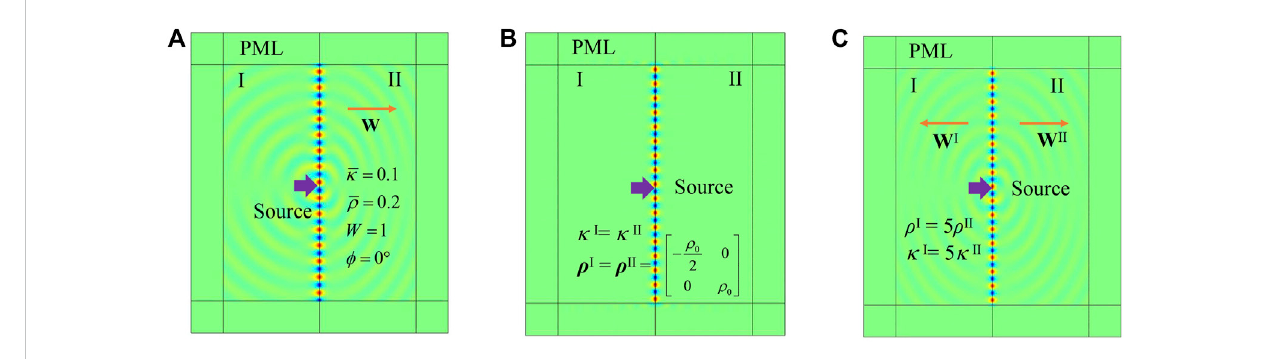
FIGURE 7 FEMsimulationsofinterfacewaves(pressure fi eld). (A) MediumI,anordinarymedium;MediumII,aWillismedium. (B) BothsidesareWillismediawith parameters that satisfy Eq. 17. (C) Both sides are Willis media with parameters that satisfy Eq. 18. In (A) , (B), and (C) , the sources are 5,000-Hz dipoles marked by